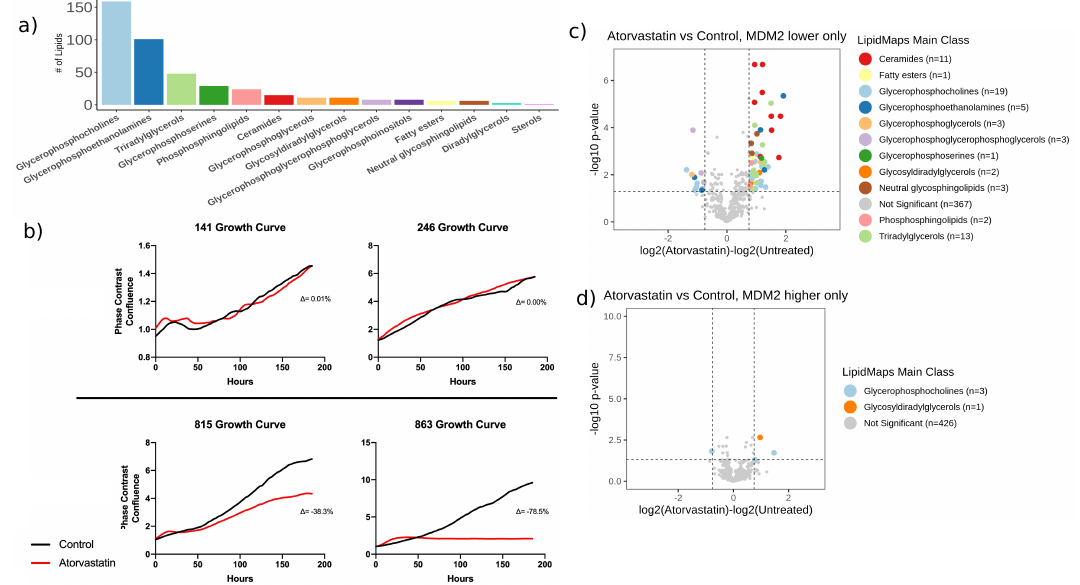
Figure 3. Effects of statin treatment on DDLPS cell lines depends on MDM2 status. ( a ) Coverage of lipids, categorized by their LipidMaps superclass. ( b ) Live cell imaging of DDLPS cell lines demonstrates differential growth patterns stratified by MDM2 status after atorvastatin treatment (average triplicate experiments). ( c , d ) We observed a more prominent dysregulation of lipids in response to atorvastatin treatment in MDM2 lower cells ( c ), compared to MDM2 higher cells ( d